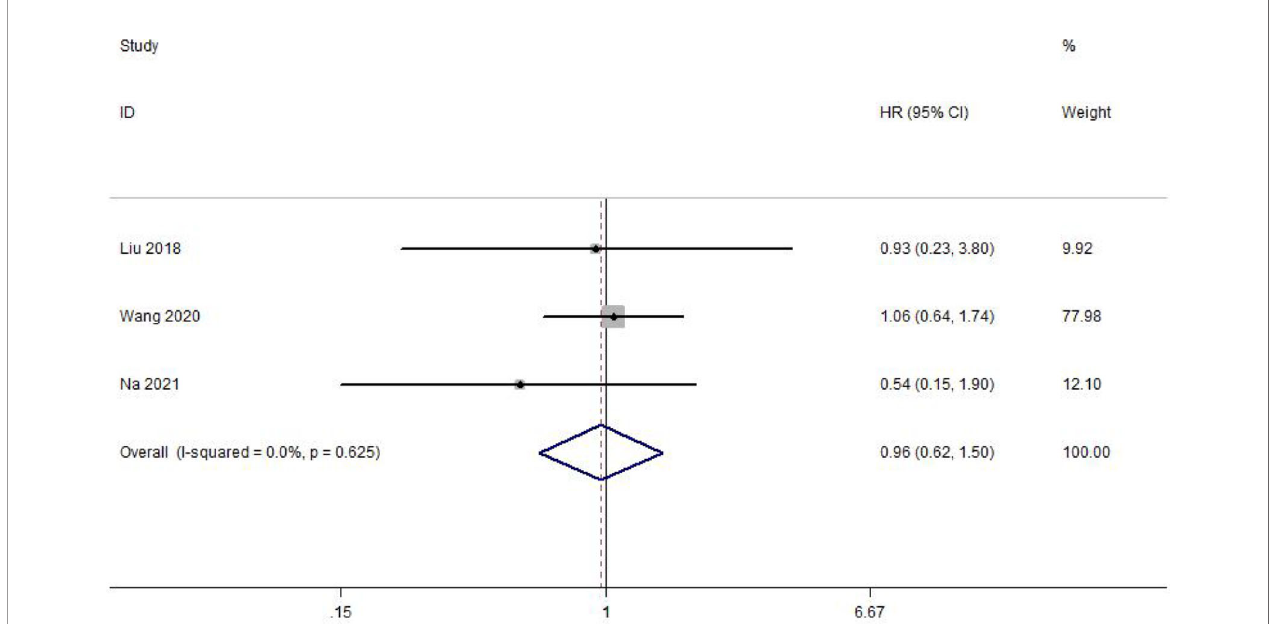
FIGURE 3 | Meta-analysis of the estimated hazard ratio for disease-free survival for a delay in gastric cancer